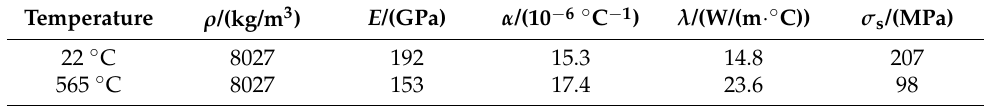
Table 1. Material parameters of valve motion components.